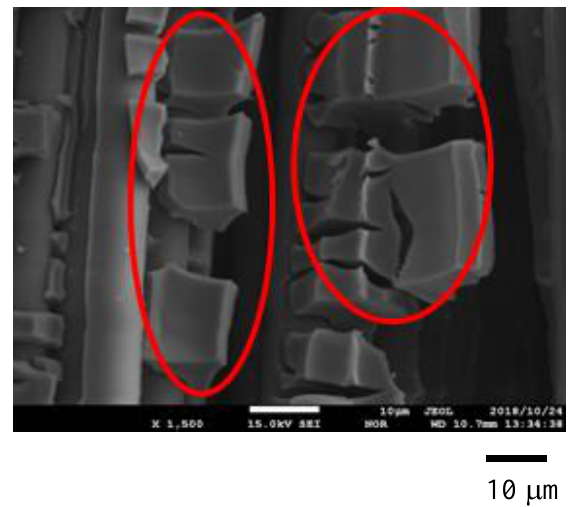
Figure 1. SEM result of TiO 2 film coated on netlike glass disc.